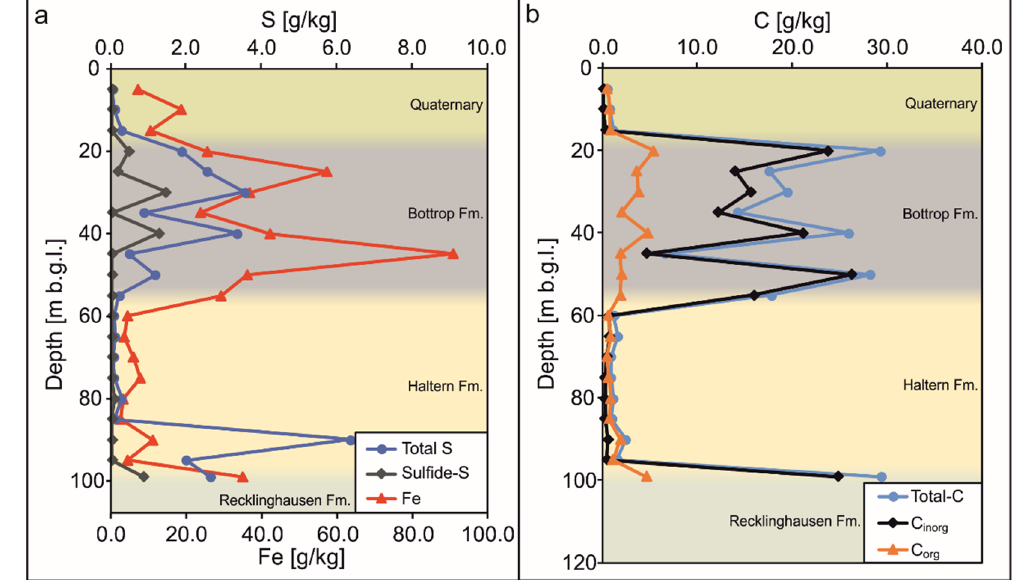
Figure 5. Sediment contents of the Haltern Fm. aquifer. ( a ) S tot , S sulf , and Fe content. ( b ) C tot , C inorg , and C org .